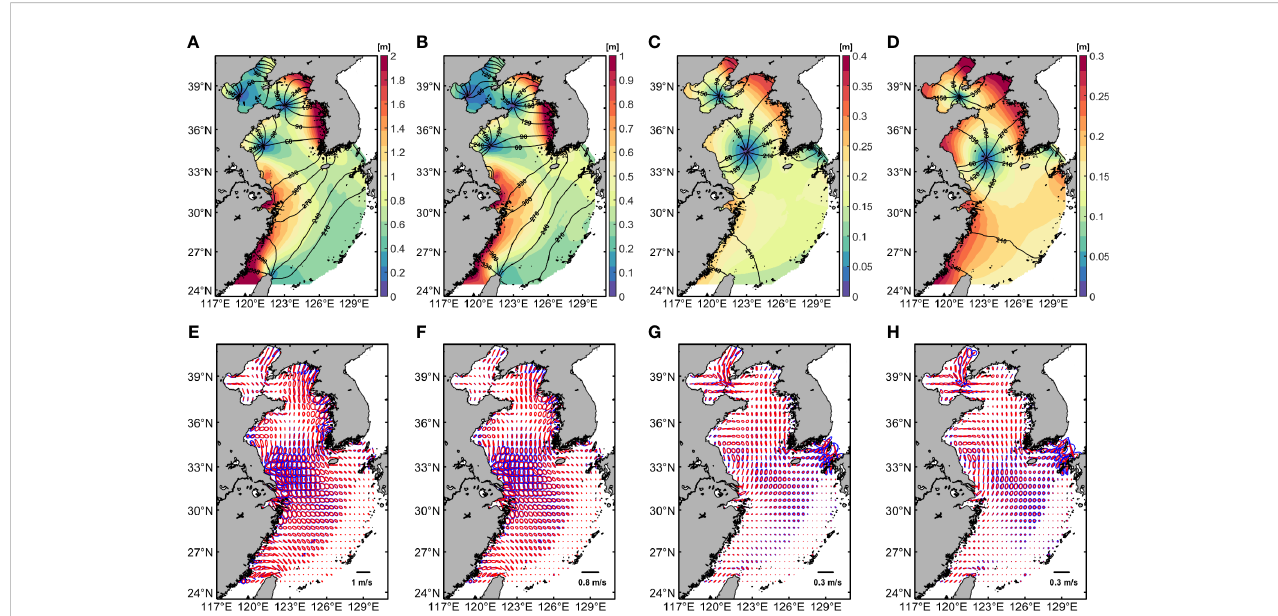
FIGURE 5 (A – D) Cotidal charts for M 2 , S 2 , K 1 , and O 1 tides in EXP 3, respectively. Colormaps denote the magnitude of the co-amplitude (m). Contour lines are the co-phase lines (°). (E – H) Tidal current ellipses for M 2 , S 2 , K 1 , and O 1 tides from the surface currents (blue) and bottom currents (red) in EXP 3, respectively.